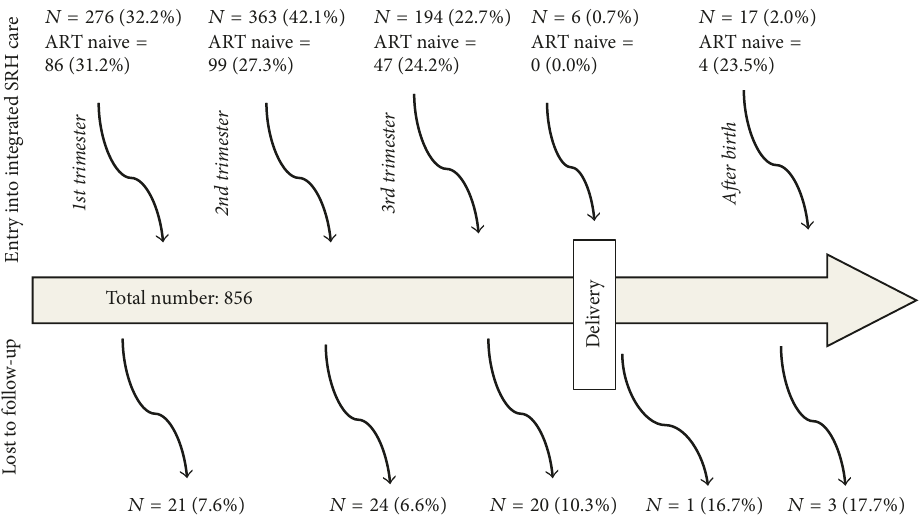
Figure 1: Showing point of entry and being lost to program by gestational age.